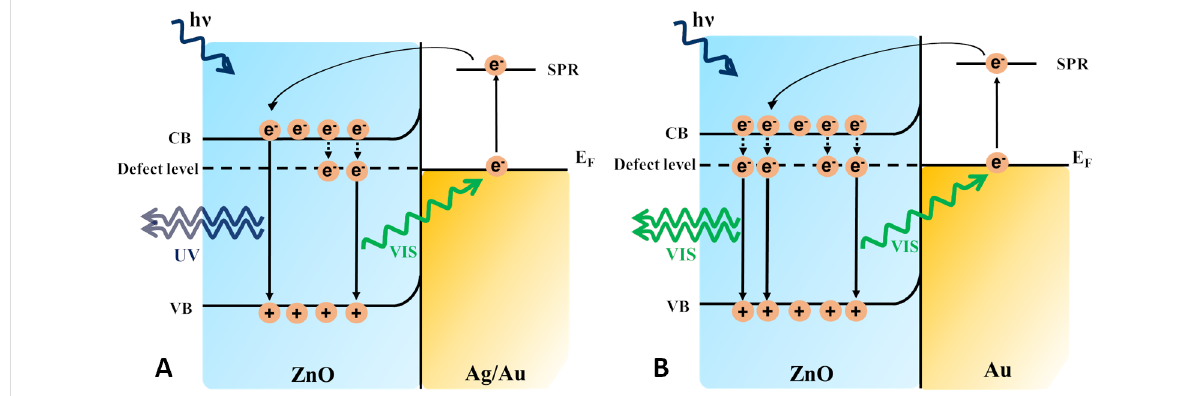
Figure 7: Schematic illustration of the mechanism for: a) UV emission enhancement of Ag NPs or Au NPs decorated ZnO and b) visible emission en- hancement of Au NPs decorated ZnO. VB-valence band; CB-conduction band; E F -Fermi level; SPR-surface plasmon resonance level.